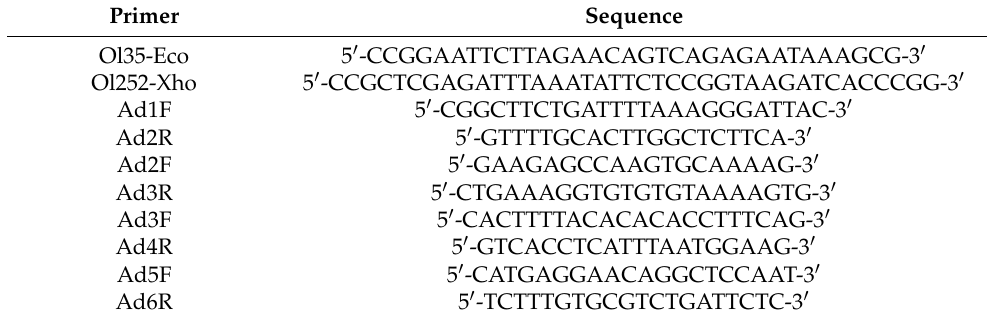
Table 3. Primers sequences. PCR was performed in a 50 µ L-final volume reaction mixture containing 1 µ M of each primer, 250 µ M of each dNTP, 1.5–2.5 mM of MgCl2 and DNA template, with